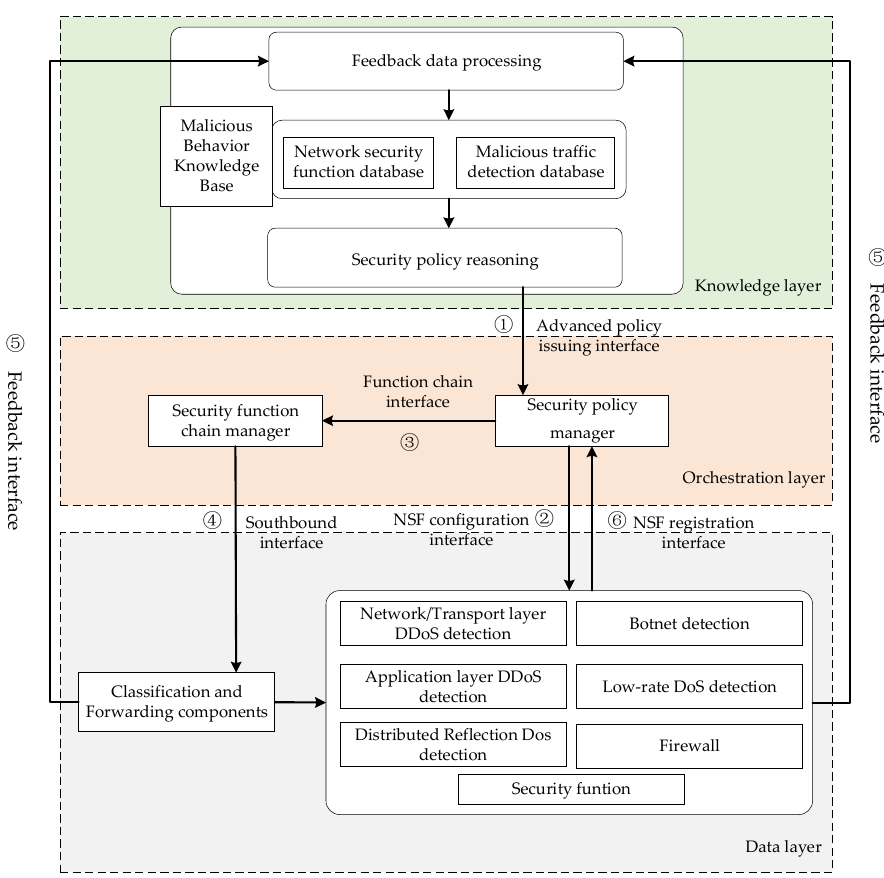
Figure 1. Block diagram of dynamic deployment of security services.